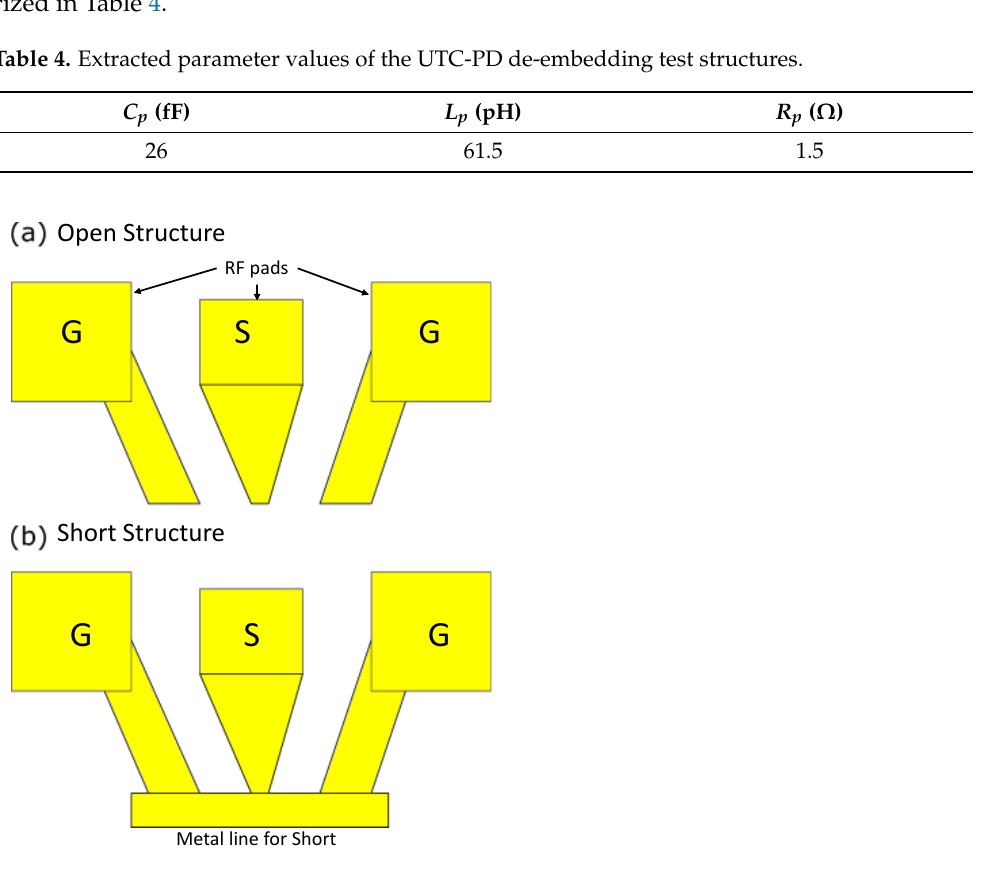
Figure 15. RF test structures with Ground-Signal-Ground (G-S-G) pads: ( a ) open and ( b ) short.